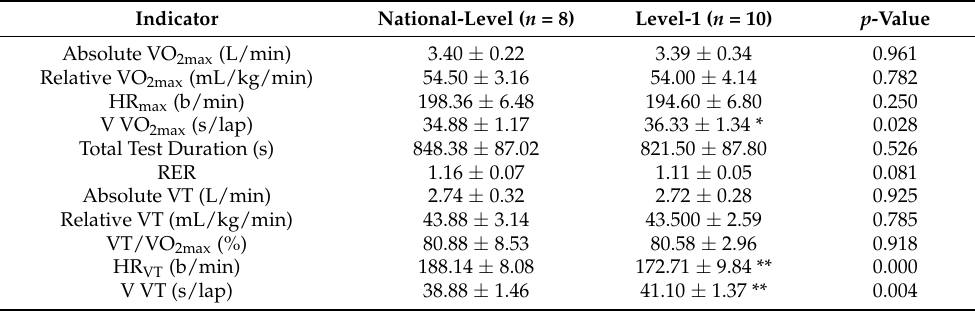
Table 7. On-Ice Aerobic Test Results for Different Levels of Elite Male Athletes.